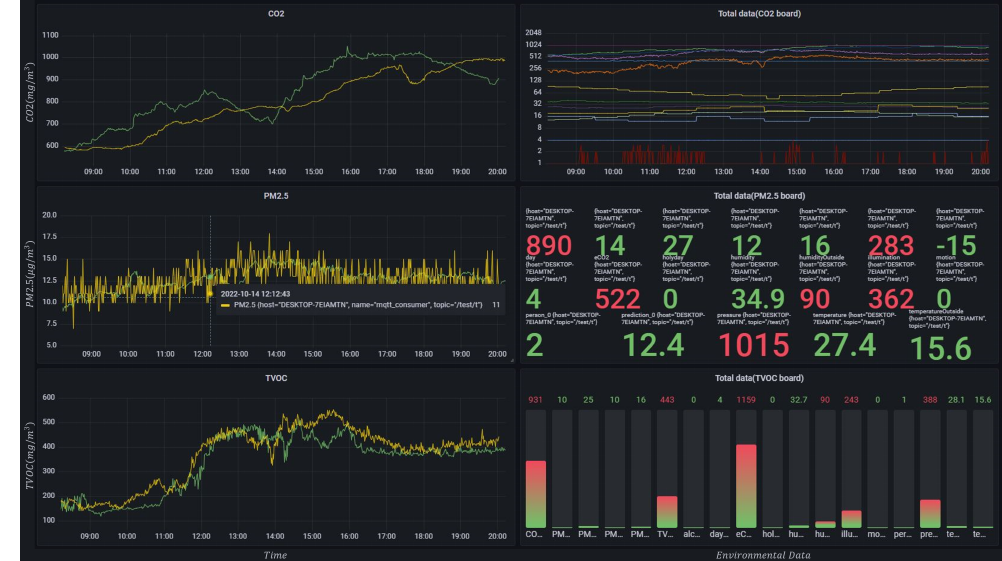
Figure 2. Multi-environment sensor monitoring